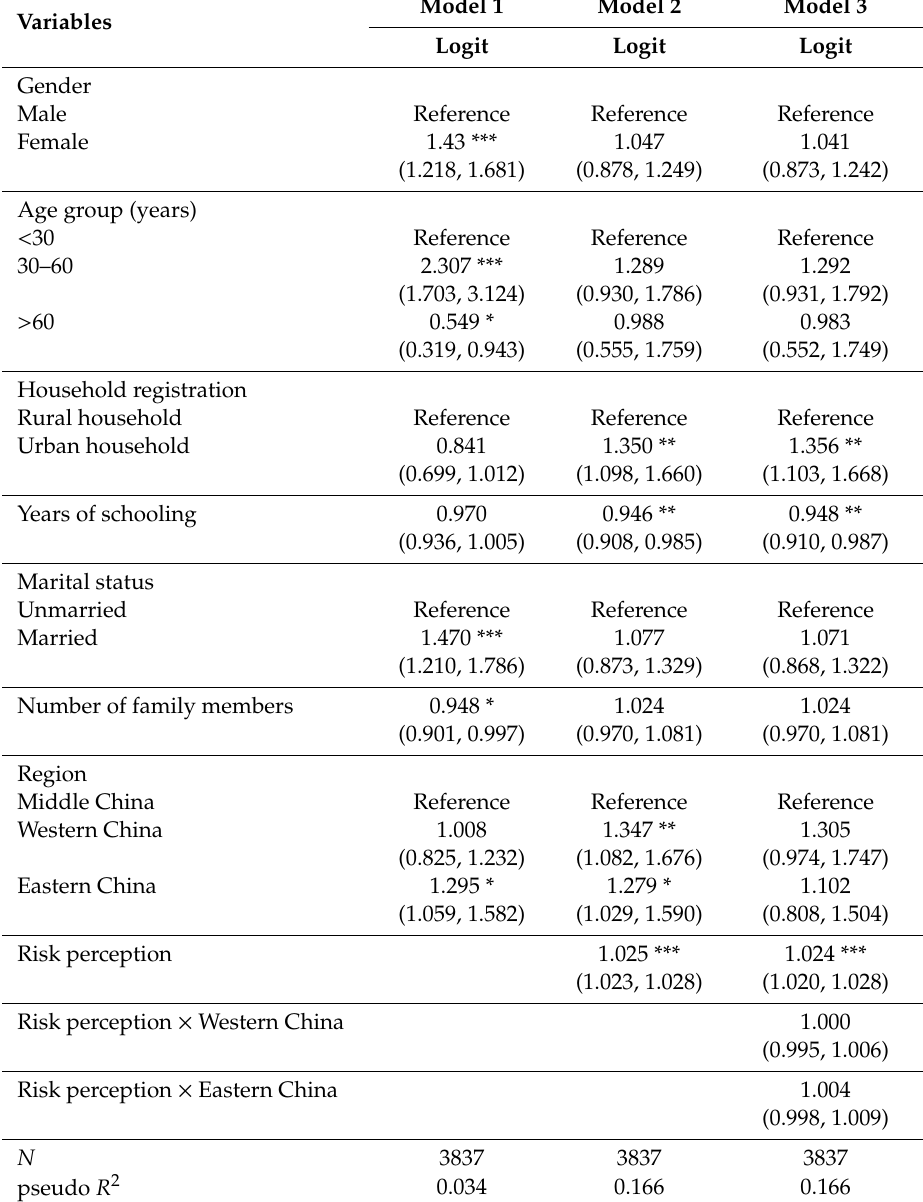
Table 4. Odds ratios and 95% confidence intervals from logit models of the public’s adoption of protective action recommendations (PARs) on risk perception and sociodemographic